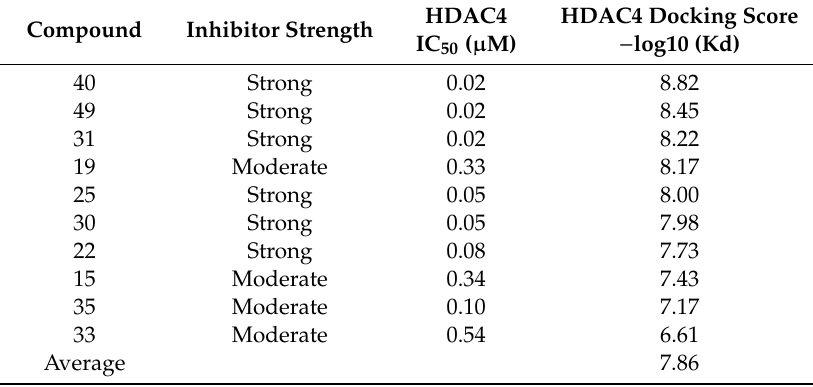
Figure 1. Structures of cyclopropane derivatives from Burli, 2013 [16] used as an original dataset. Table 1. Docking scores of original cyclopropane derivatives in histone deacetylase 4 (HDAC4) and histone deacetylase 5 (HDAC5) receptors.